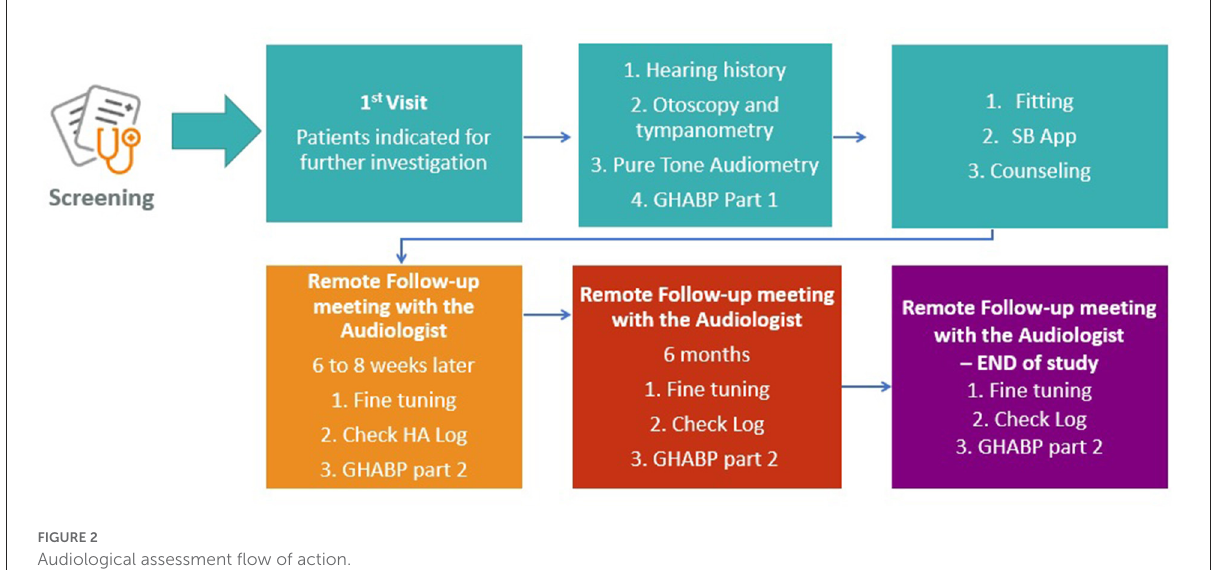
FIGURE2 Audiological assessment flow of